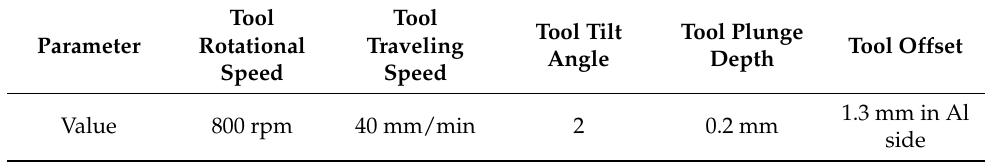
Table 2. Chemical composition of base metals. Table 3. Friction stir welding (FSW) process parameters.